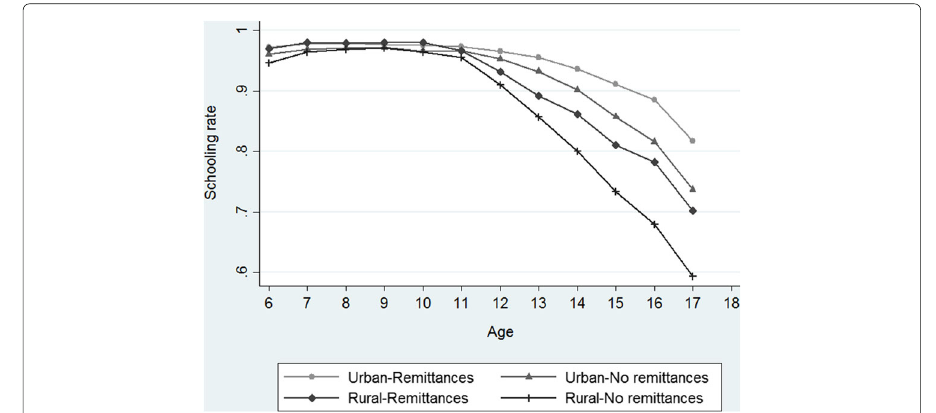
Fig. 1 Schooling rate by rural/urban region and remittance reception